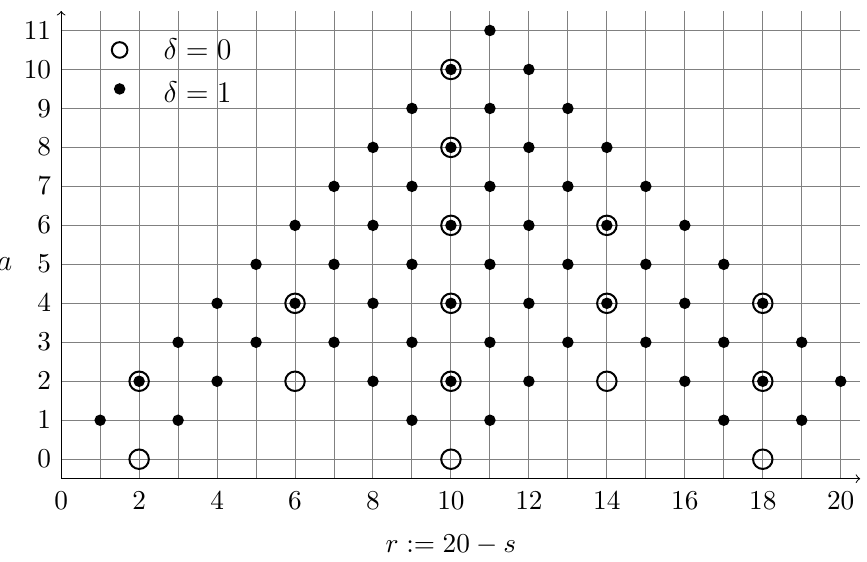
Figure 1 . Points ( r, a, δ ) determining all 75 invariant lattices of signature ( r − 1 , 1) which are embedded primitively in the K3 lattice Γ (19 , 3)